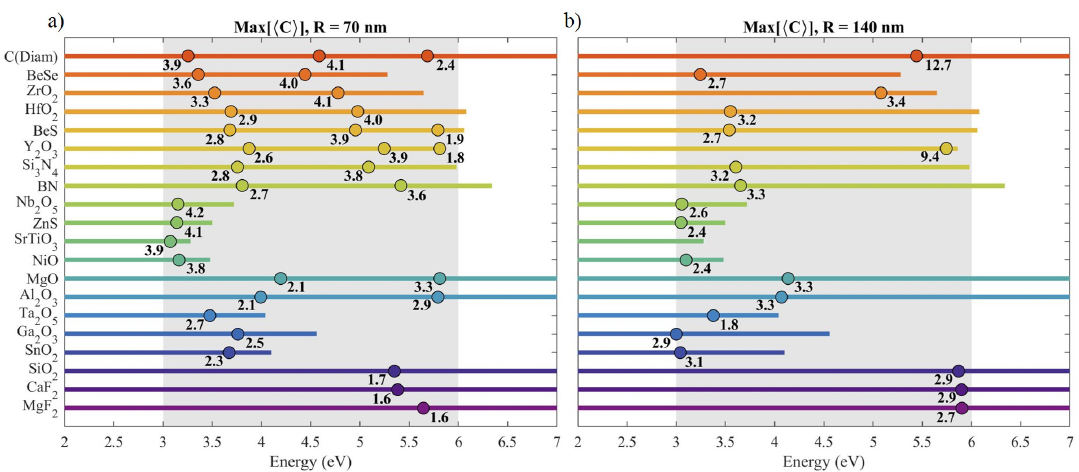
Figure 6. Spectral maximum of surface averaged OCD enhancement for 70 nm ( a ) and 140 nm ( b ) radius nanospheres.